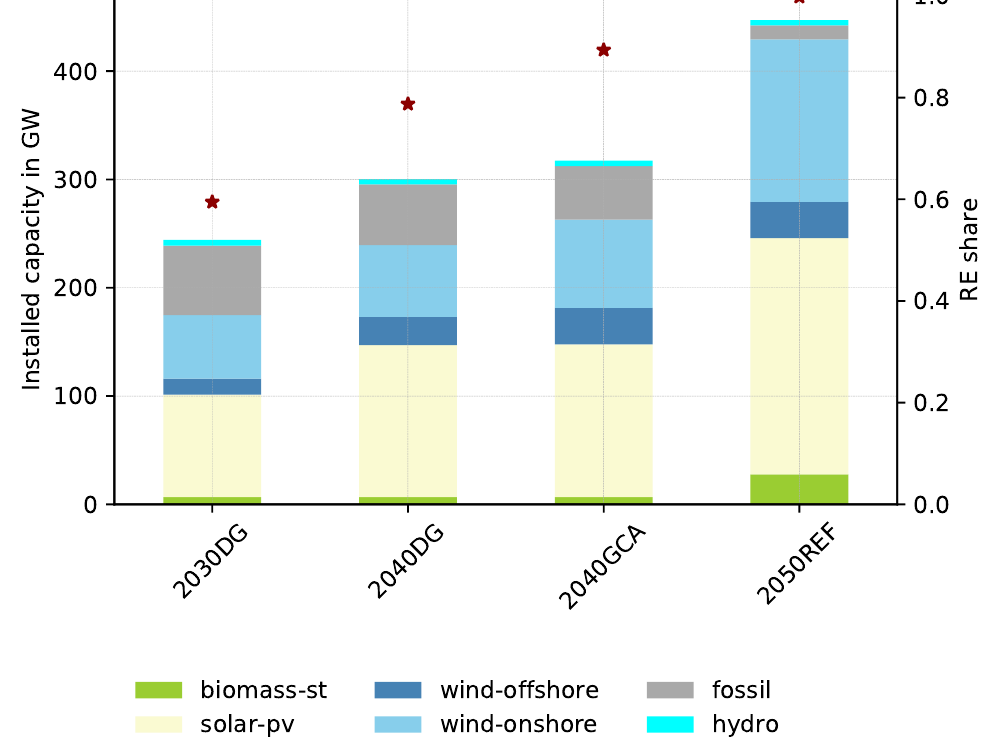
Figure 2. Installed generation capacities in Germany (DE) for all